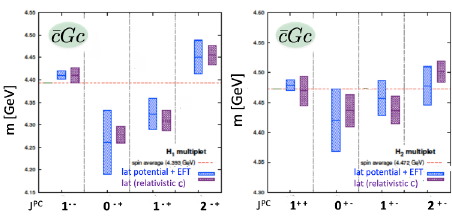
Figure 9. Masses of ¯ cGc hybrids from hybrid potentials [35, 36] (blue) and from relativistic c quarks [38] (violet).